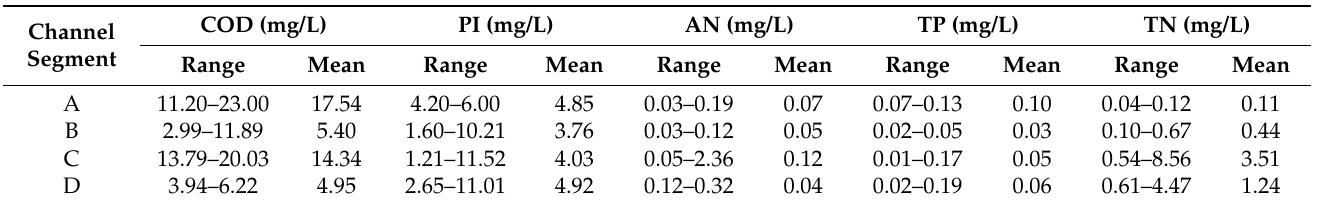
Table 1. Statistical values of water quality parameters of different dates consisting of 184 sampling test data.